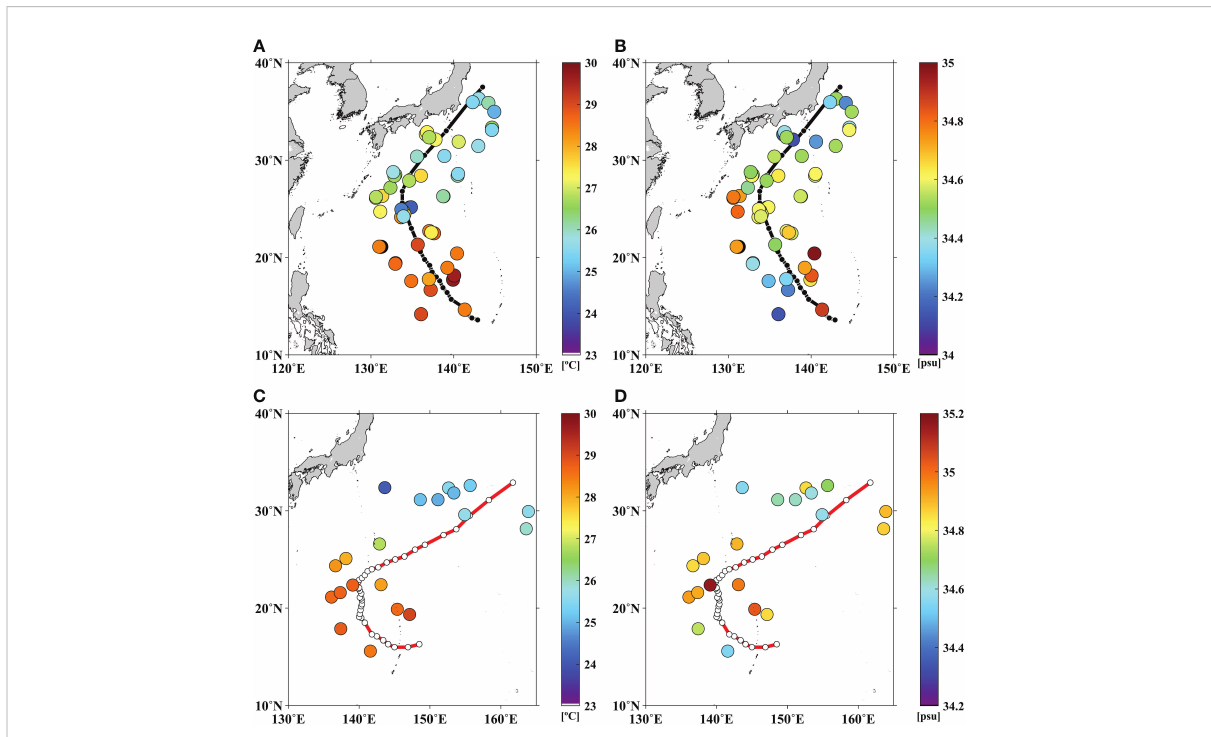
FIGURE 9 Scatter plots of (A) surface temperature (°C) and (B) surface salinity (psu) observed by Argo fl oat during Typhoon Wipha from 10 – 16 October, 2013. (C) and (D) are the same as (A) and (B) for Typhoon Champi from 13 – 25 October, 2015. The black and red lines represent the typhoon